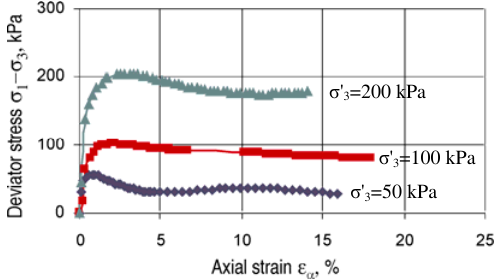
Fig 9 . Deviator stress against strain of CU triaxial comp- ression test